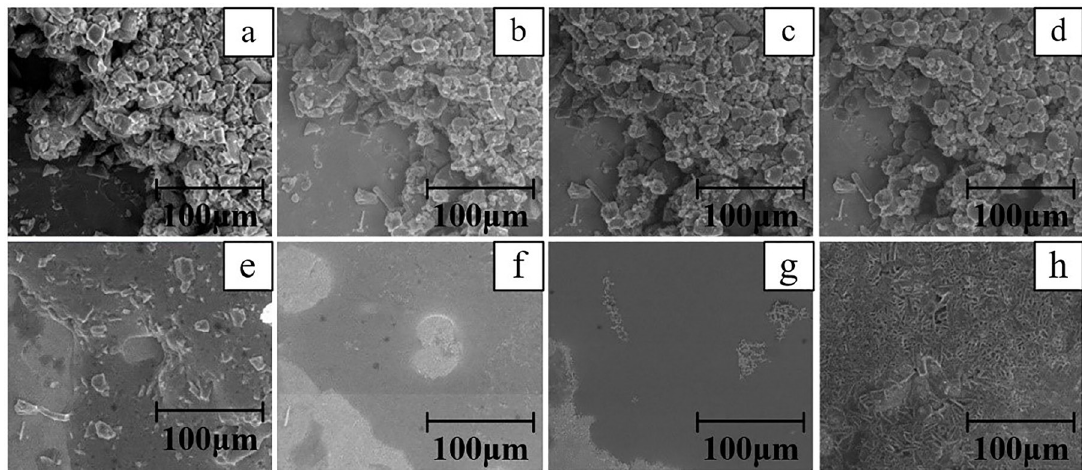
Figure 9: In situ micrographs of studied enamel during heating at different temperatures [52]